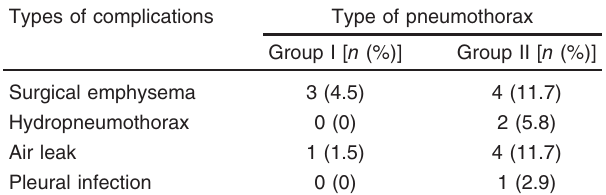
Table 6 Descriptive data of the types of complications in the studied patients